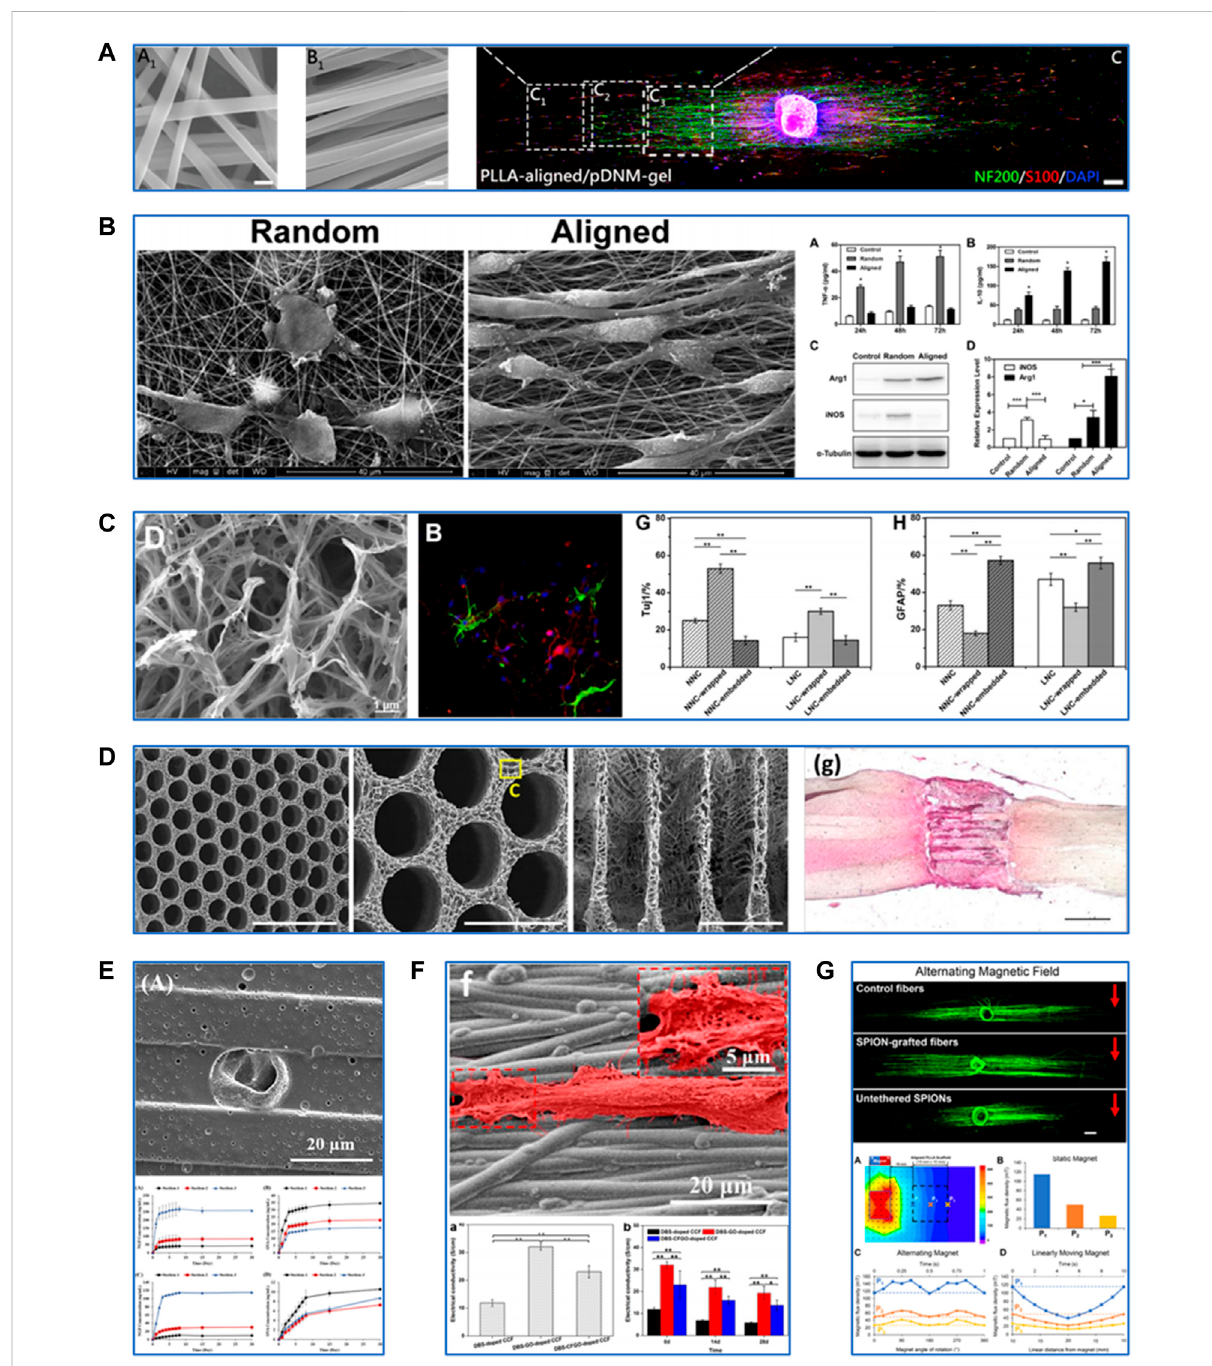
FIGURE 1 Fabrication and modi fi cation techniques of PLLA-based scaffolds for neural tissue engineering. (A) Characterization of PLLA-based scaffolds fabricated by electrospinning and their effects on neurite growth and Schwann cell migration. Reproduced with permission from Ref. (Chen S. et al., 2019). Copyright 2019, American Chemical Society. (B) Characterization of PLLA-based scaffolds fabricated by electrospinning and their effects on macrophagepolarization. Reproducedwith permission fromRef.(Jiaetal., 2019).Copyright 2018,Elsevier. (C) Characterization ofPLLA-based scaffolds fabricated by thermally induced phase separation and their effects on differentiation of neural stem cells into neurons. Reproduced with permission from Ref. (Liu et al., 2018). Copyright 2017, Elsevier. (D) Characterization of PLLA-based scaffolds fabricated by additive manufacturing and their effects on spinal cord regeneration. Reproduced with permission from Ref. (Kaplan et al., 2020). Copyright 2020, Elsevier. (E) Modi fi cation of PLLA-based scaffolds by drug delivery. Reproduced with permission from Ref. (Uz et al., 2017). Copyright 2016, Elsevier. (F) Modi fi cation of